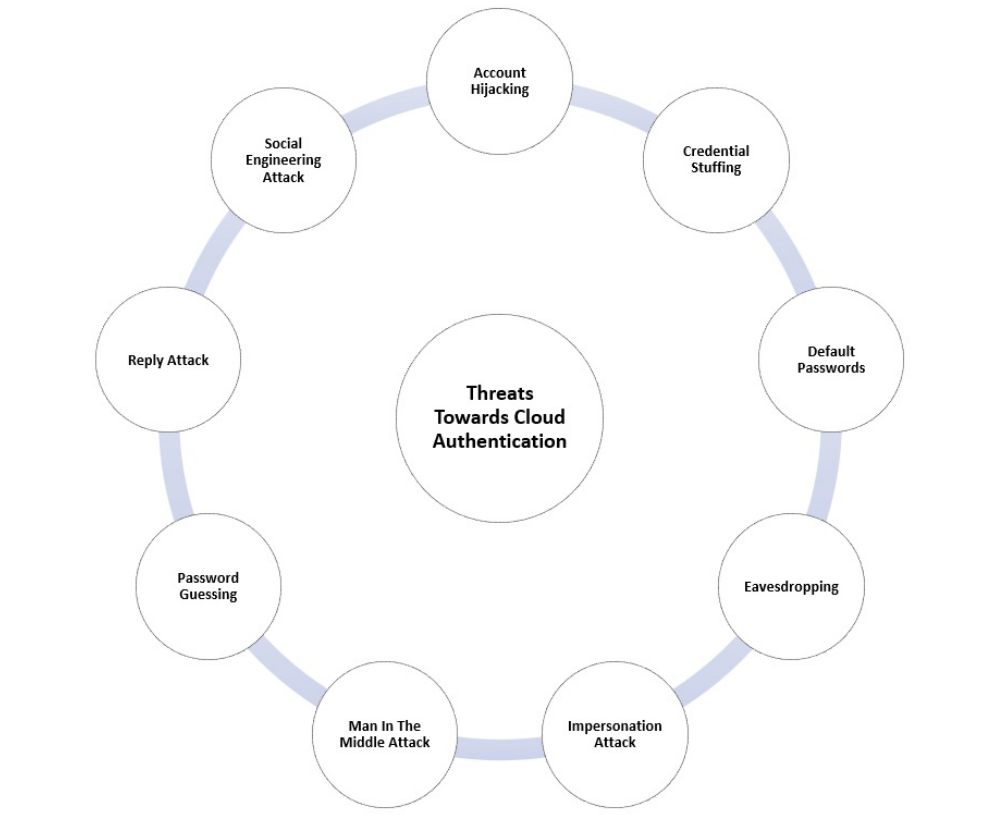
Figure 2. Contributors Towards Cloud